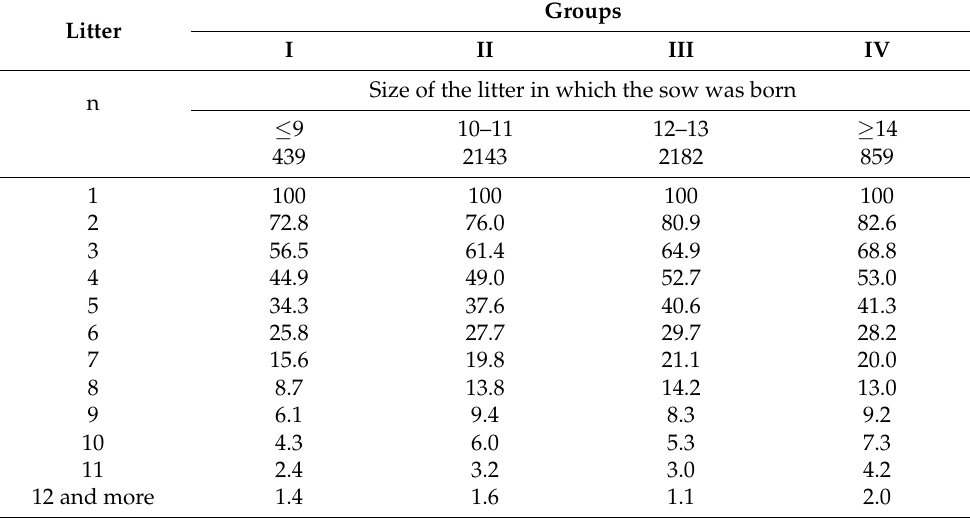
Table 2. Percentage of sows in each group, which have given birth to further parity.